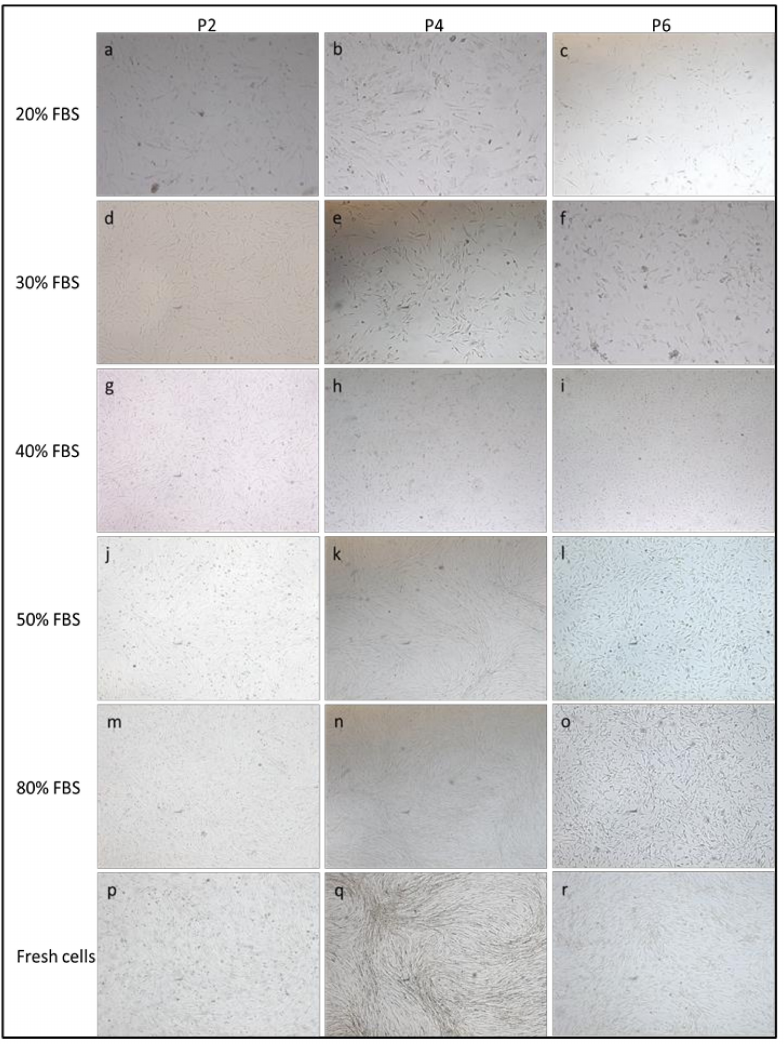
Figure 1. Morphology of cell cryopreserved with 10% DMSO—20%, 30%, 40%, 50% and 80% FBS percentages and fresh cells showed at passages P2 ( a , d , g , j , m , p ), P4 ( b , e , h , k , n , q ) and P6 ( c , f , i , l , o , r ). Cells frozen with FBS concentrations lower than 50%, after thawing, particularly in the passages P4–P6, showed an altered morphology, fusiform, polygonal, astroid shapes and a stunted growth in culture failing to reach semi-confluence. Cells from P2 to P6 passages, cryopreserved with serum percentages greater than 50%, maintained the ability to expand in culture and reached semiconflu- ence. Thawed cAD-MSCs presented fibroblast-like phenotype until passages P4 and demonstrated increased volume and cuboidal shape at P6 as in their fresh counterpart. A 100 ×